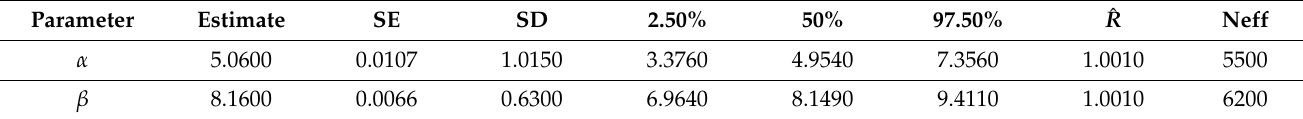
Table 4. Posterior summaries of the parameters of the AP distribution.